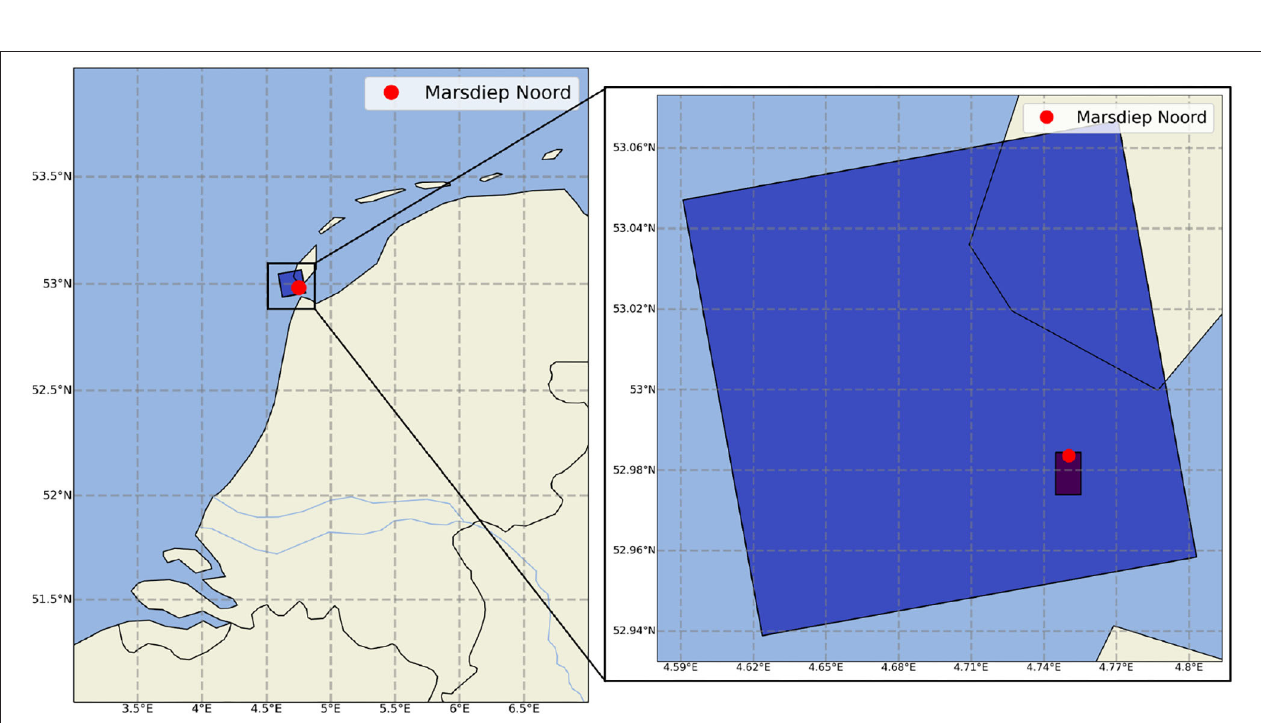
FIGURE 2 | Location of the study area and the monitoring point together with the pixels of the matching Euro-CORDEX climate model output and CMEMS satellite measured chlorophyll-a.